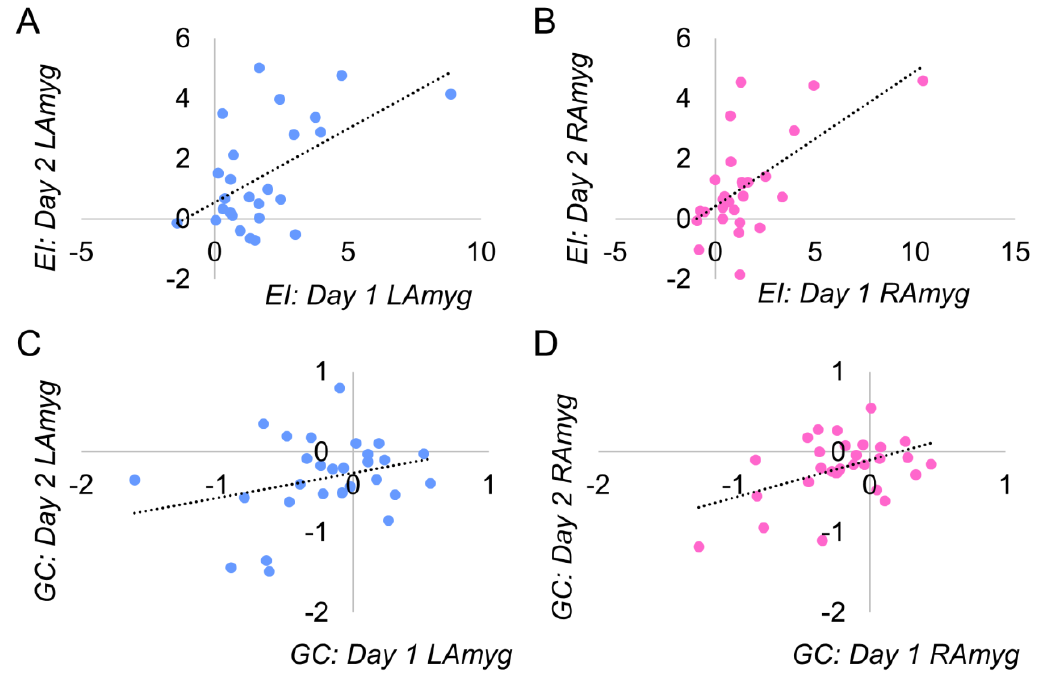
Figure 3. Distribution of PPI effect averaged across days. The regions displayed exceeded our threshold for reliability (ICC > 0.4, see Table 1 for full statistics). The sgACC in the EI task did not exceed our threshold for reliability and is not displayed. EI=emotion identification; GC=gender classification; threshold for reliability and is not displayed. EI = emotion identification; GC = gender classification; LAmyg=left amygdala; RAmyg=right amygdala. LAmyg = left amygdala; RAmyg = right